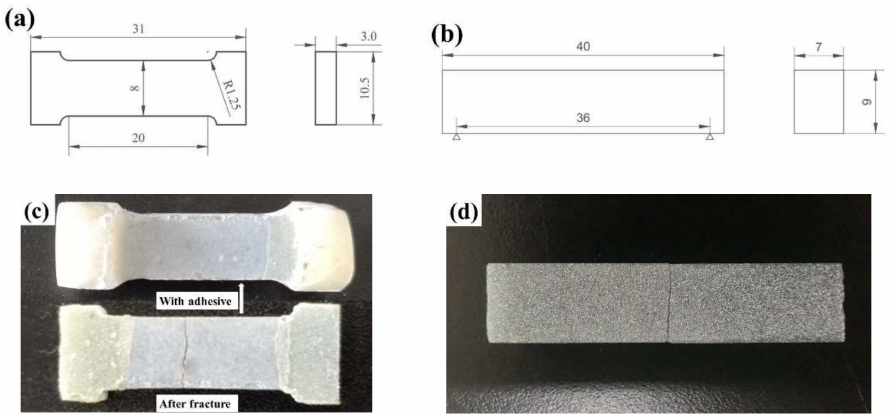
Figure 1. Dimension of the ( a ) tensile specimen; ( b ) 3PB specimen (unit: mm); ( c ) Image of tensile specimen with adhesive and that after fracture at 400 ◦ C; ( d ) Image of 3PB specimen after fracture at